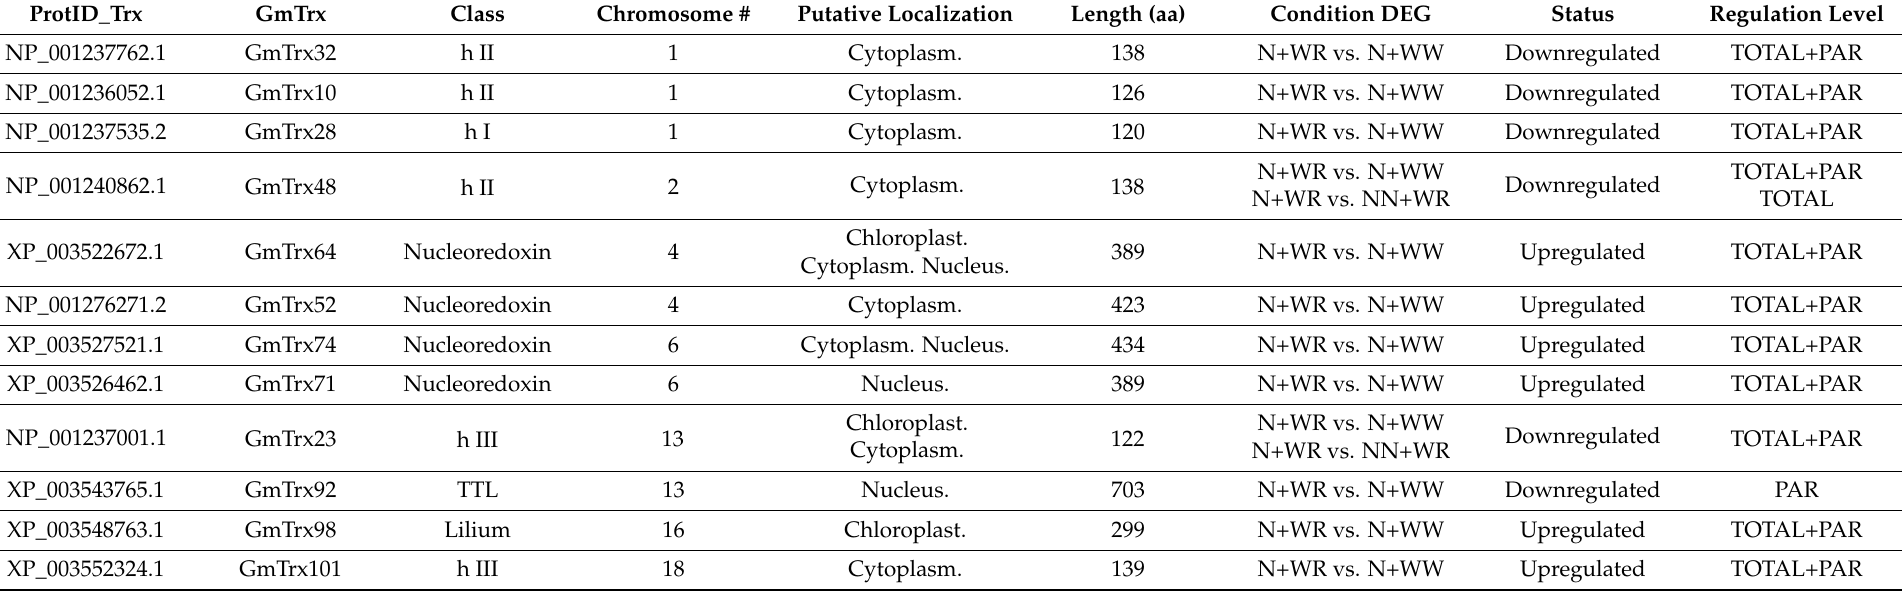
Table 1. Differentially expressed GmTrx in nodulated and water-restricted plants. The class, chromosome localization, subcellular putative localization, and protein length are shown. The contrast (N+WR vs. N+WW and/or N+WR vs. NN+WR) in which the DEG condition was achieved together with the status (up- or down-regulated) and the regulation level (TOTAL, PAR, or TOTAL+PAR) are also